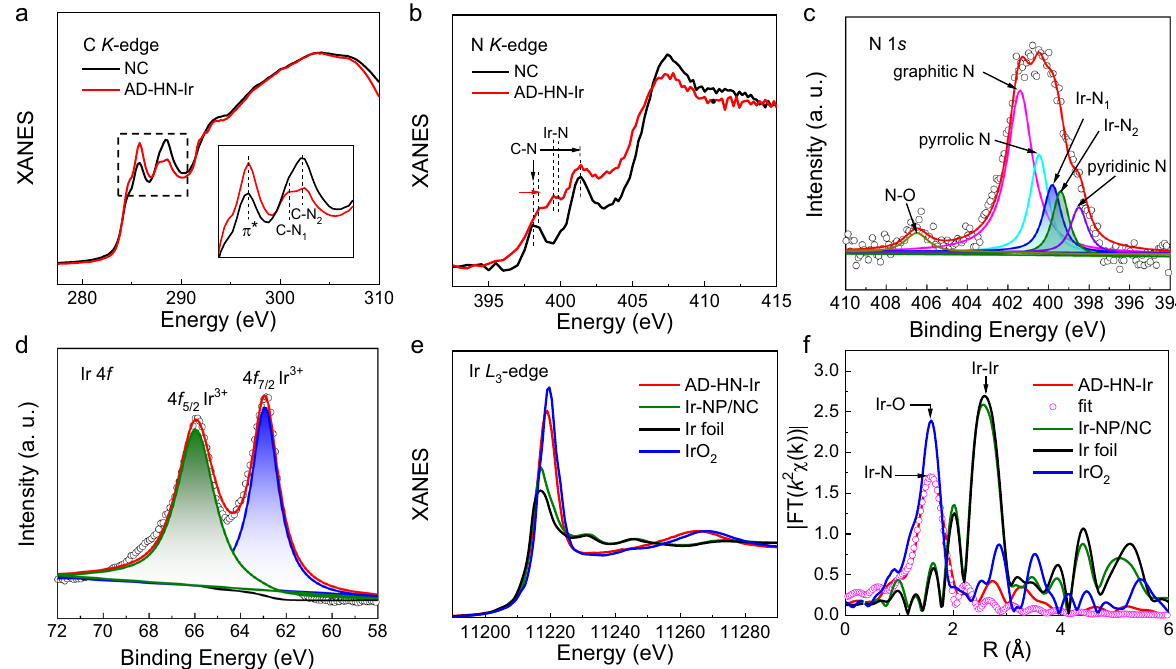
Fig. 2 Electronic structural characterizations of AD – HN – Ir electrocatalyst. a C and b N K -edge XANES spectra of NC and AD – HN – Ir electrocatalysts. c N 1 s and d Ir 4 f XPS spectra of AD – HN – Ir electrocatalyst. e Ir L 3 -edge XANES spectra and f Fourier transforms (FTs) of the Ir L 3 -edge EXAFS oscillations